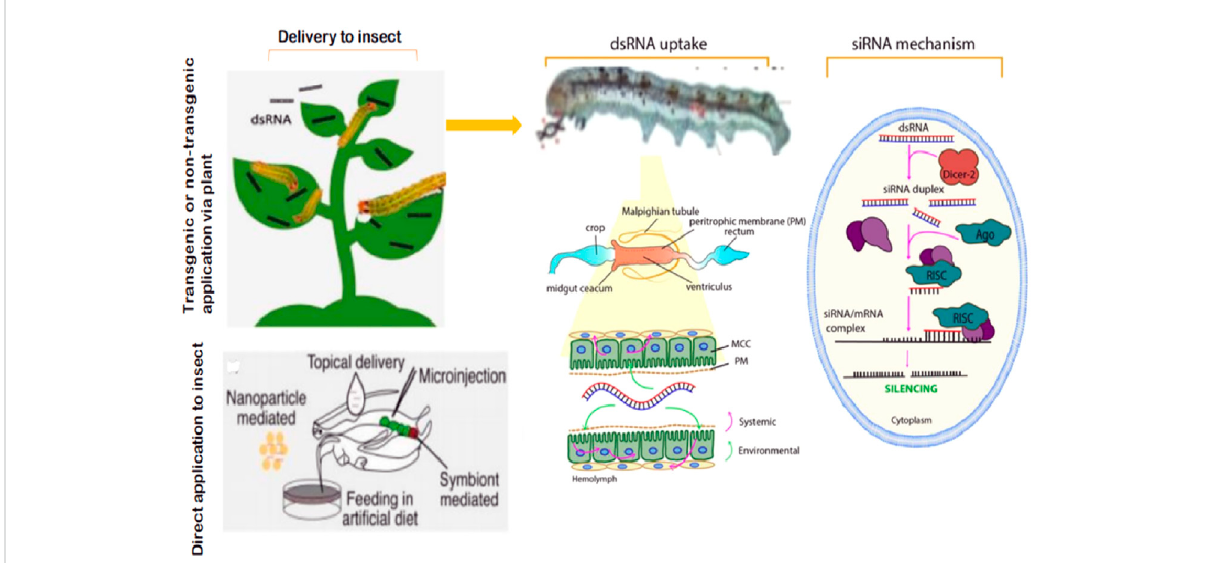
FIGURE 2 Application strategies and the basic cellular mechanism of RNAi-mediated plant protection from a lepidopteran pest control